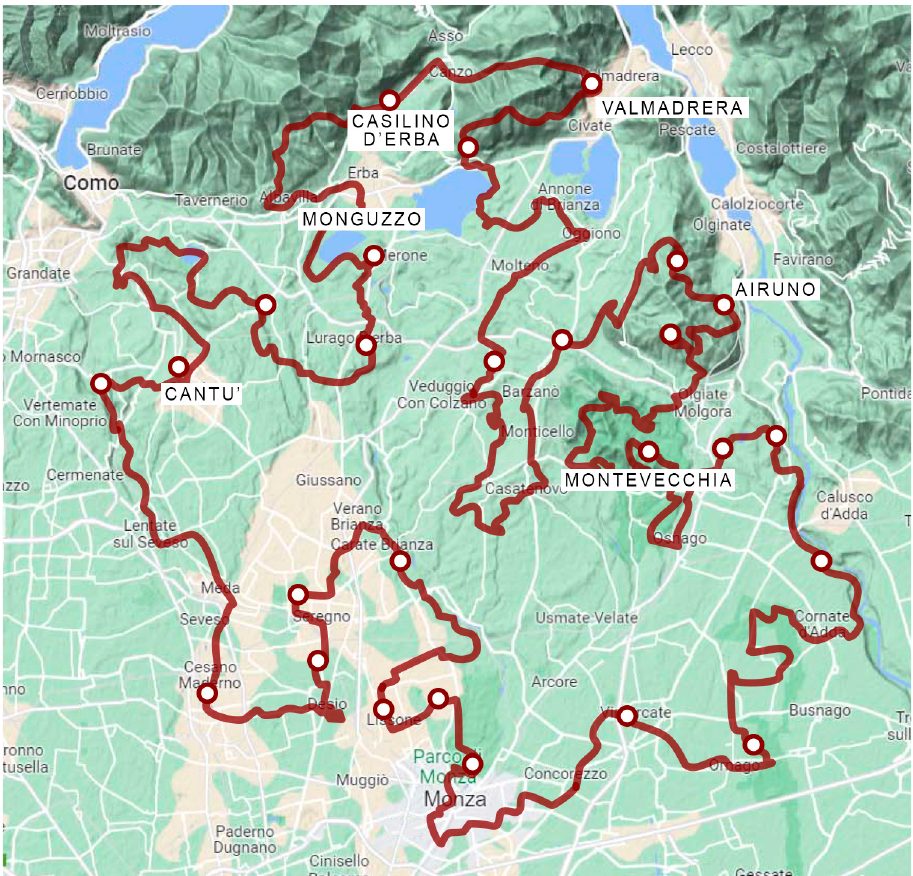
Figure 2. General map of the path of St. Augustine with the location of Airuno and the six locations of the sanctuaries of Figure